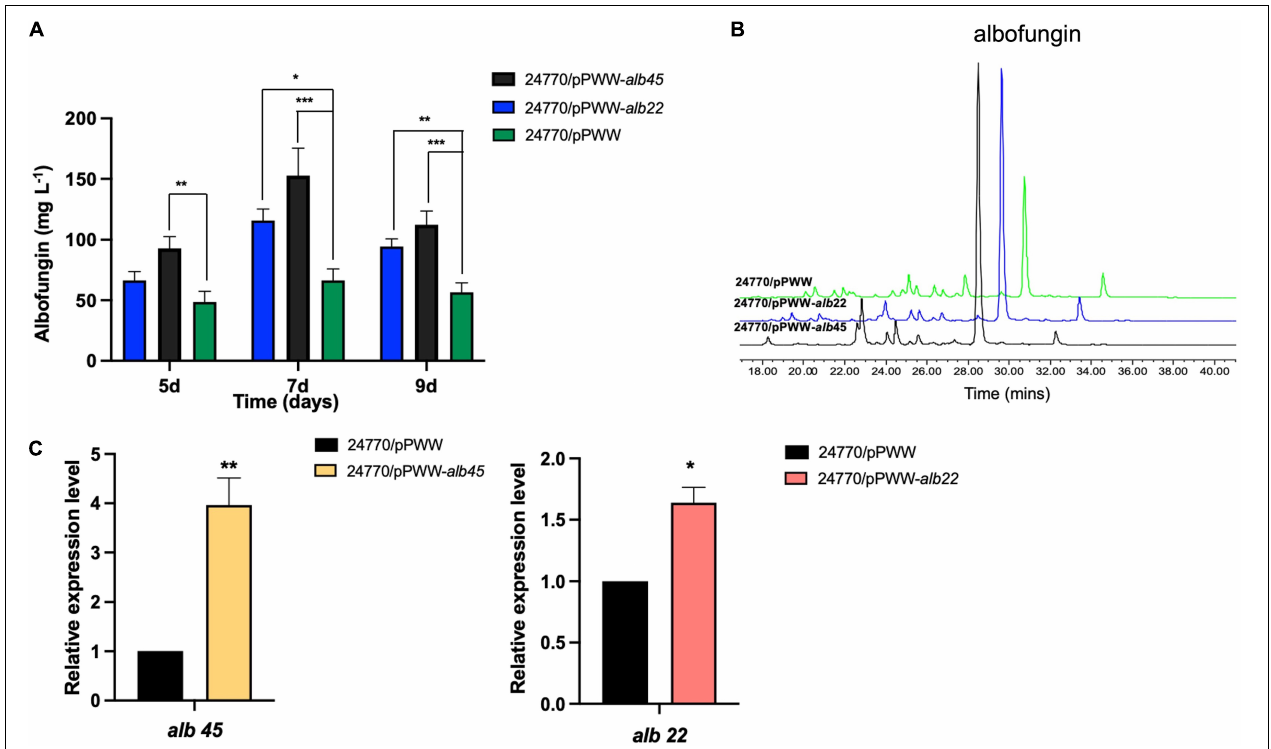
FIGURE 4 | Effects of overexpressed regulators on albofungin production. (A) Albofungin production (mg L − 1 ) by 24770/pPWW (parental strain), 24770/pPWW- alb22 and 24770/pPWW- alb45 overexpression strains. Error bars represent SD, n = 3 independent cultures. Significant differences were analyzed by one-way ANOVA, * p < 0.05, ** p < 0.01, and *** p < 0.001. (B) HPLC analysis (300 nm) of the crude extracts of 24770/pPWW, 24770/pPWW- alb45 and 24770/pPWW- alb22 at 7 days. (C) Relative expression level of alb45 and alb22 in 24770/pPWW, 24770/pPWW- alb45 and 24770/pPWW- alb22 strains. GAPDH was used as a reference gene, and 24770/pPWW served as a control. Error bars represent SD, n = 3 independent cultures. Significant differences were analyzed by Student’s t -test, * p < 0.05, ** p < 0.01, and *** p <